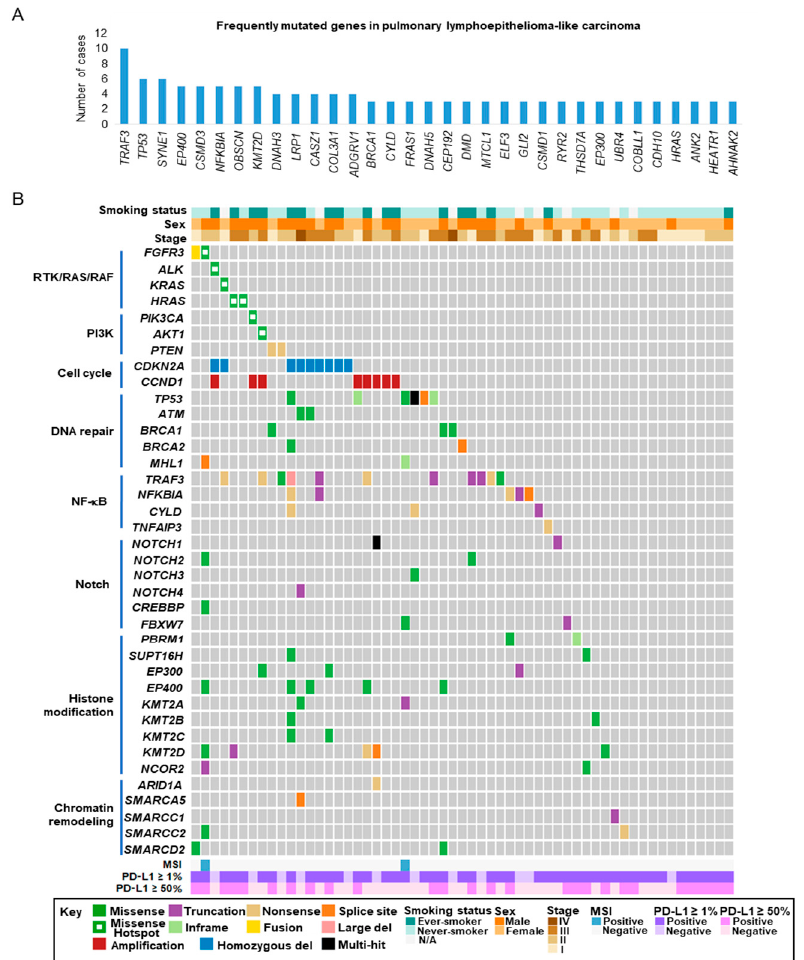
Figure 3. Landscape of molecular alterations in pulmonary lymphoepithelioma-like carcinoma. ( A ) Frequently mutated genes discovered by targeted sequencing. ( B ) Spectrum of key